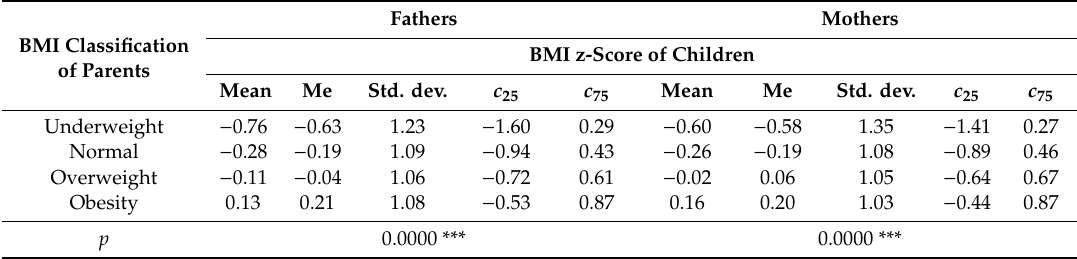
Table 2. Z-score classification depending on the body mass index (BMI) of fathers and mothers. BMI Classification of